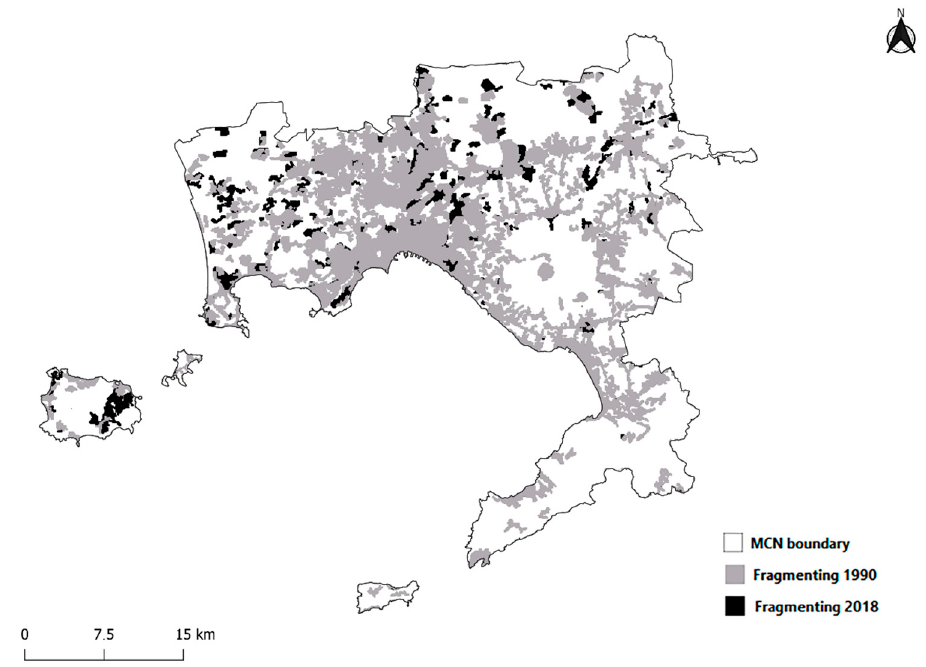
Figure 2. Fragmenting of the Metropolitan City of Naples (MCN)’s eco-mosaic in 1990 (grey layer) and 2018 (black layer). The overlap between the two layers highlights the increase in fragmenting that occurred in the last three decades (black polygons).